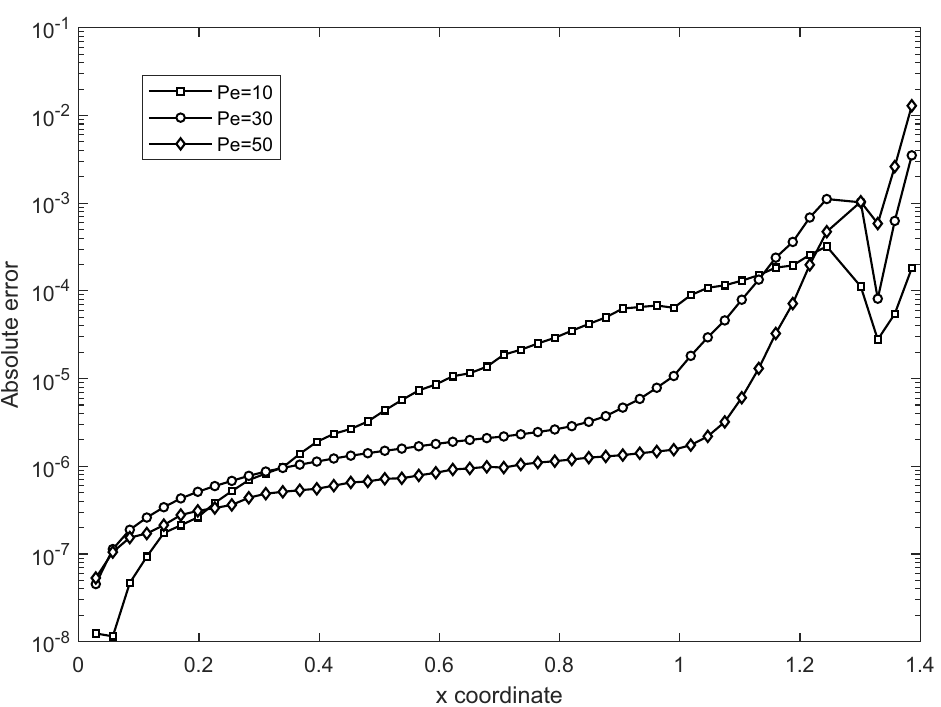
Figure 3. Example No. 1—irregular mesh, absolute errors in the profile x =